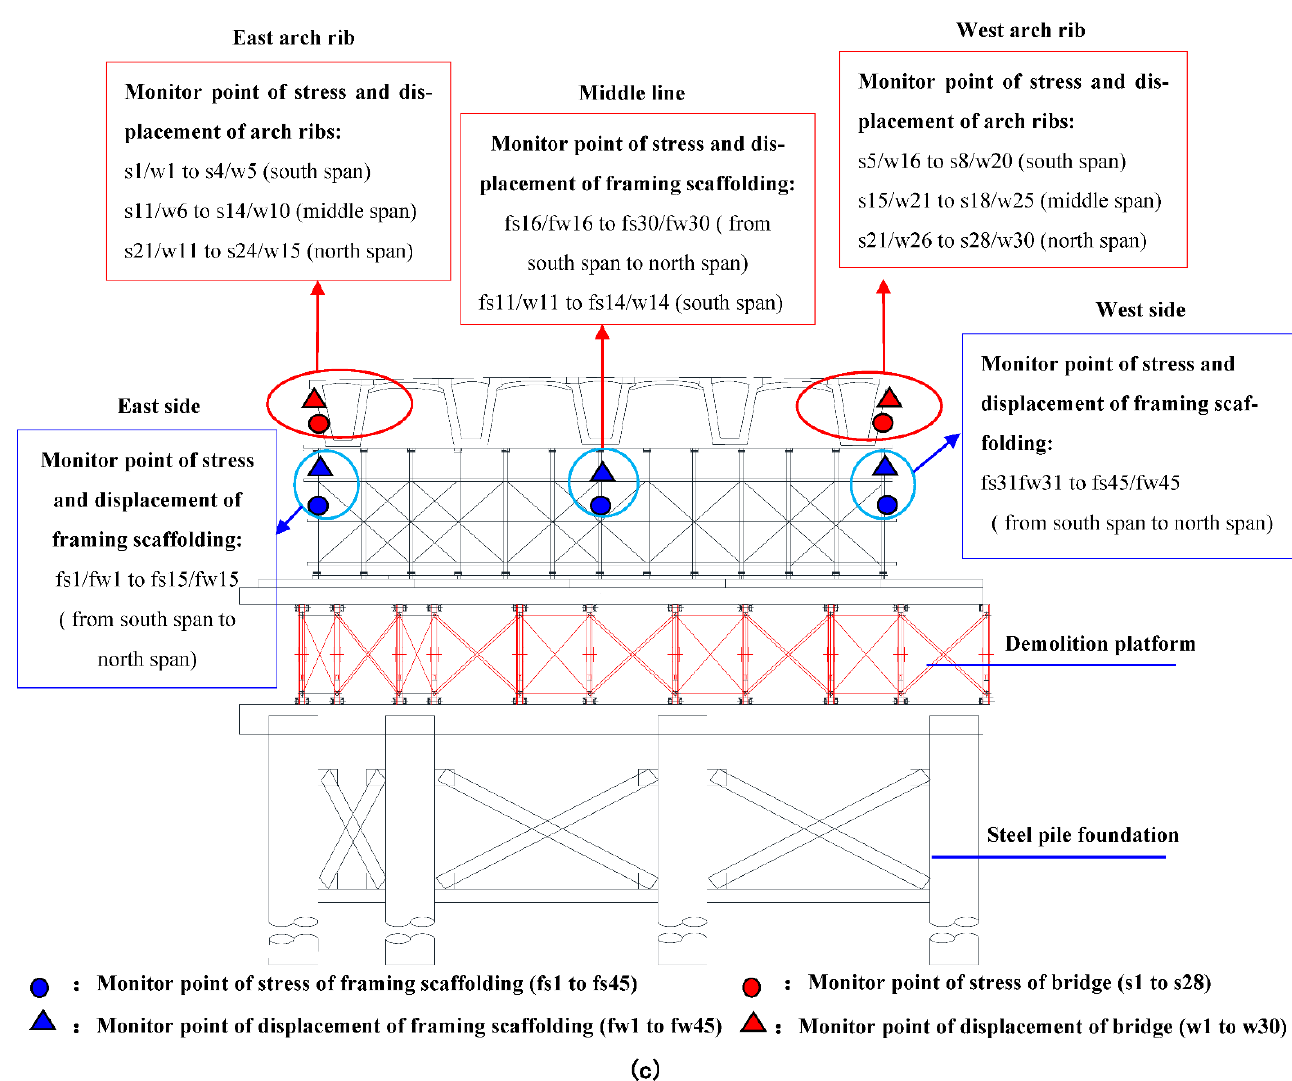
Figure 3. Monitor points of the arch rib and framing scaffolding during the nearby and demolition construction: ( a ) The cross-section of monitor points of the arch rib and framing scaffolding; ( b ) Plane-view diagram of the numbered rule of the monitor points; ( c ) The cross-section of monitor points of the arch rib and framing scaffolding.